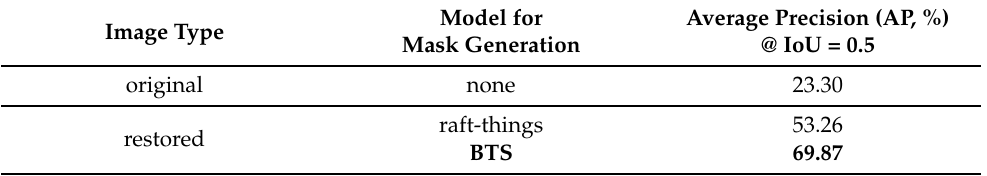
Figure 14. Object detection results: ( a ) original image sequence; ( b ) object detection before image restoration; ( c ) result comparisons; ( d ) object detection after image restoration. The wiper truncates (blue dashed box) or occludes (green dashed box) frontal objects, which causes erroneous object detection results regarding prediction properties of objects. Best viewed with zoom-in. Table 5. Quantitative results: average precision (AP) comparison of object